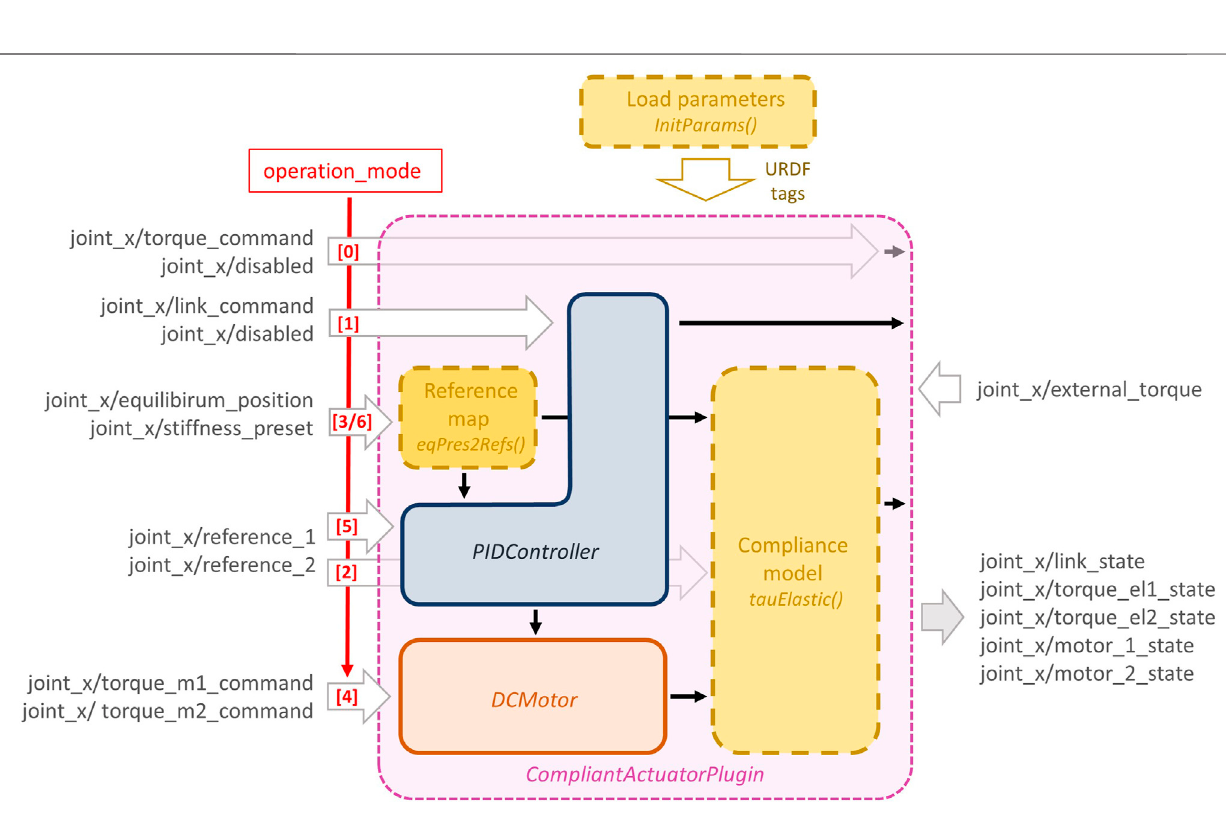
Frontiers in Robotics and AI |